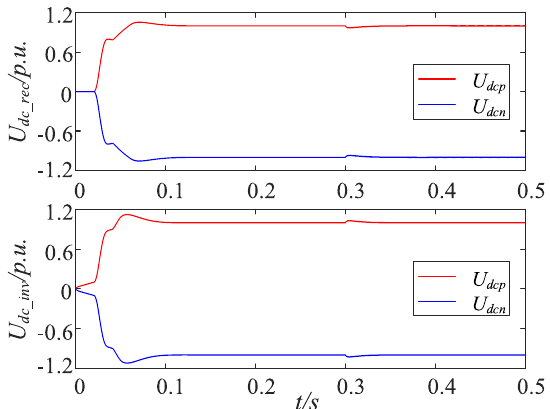
Fig. 22 DC bus voltage waveform during LVRT operation of